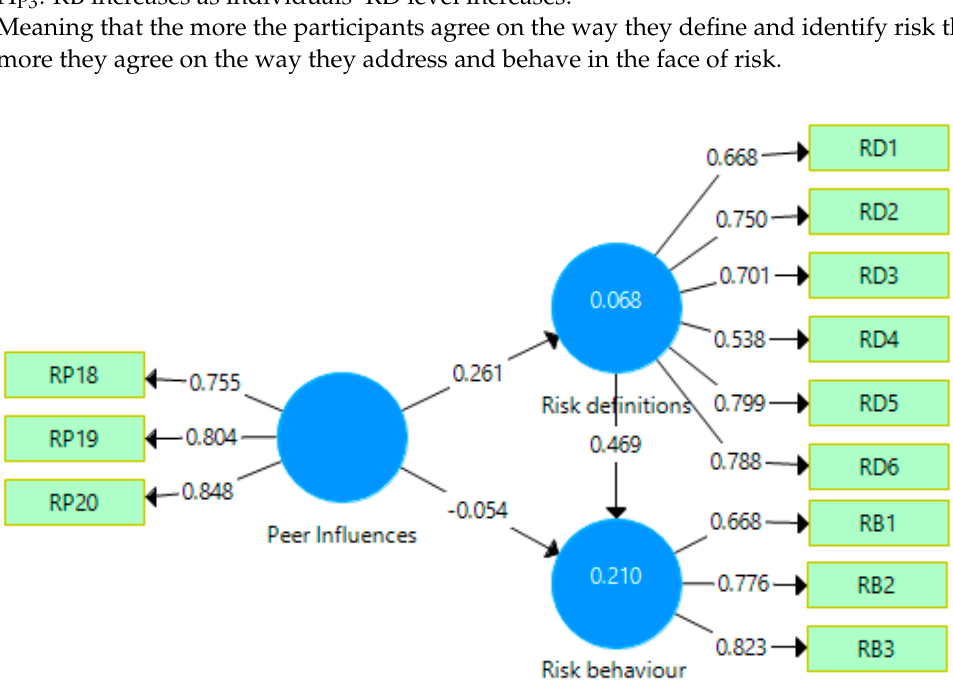
Figure 6. Model Five Structural Path Graph (Source: Authors’ Compilation).